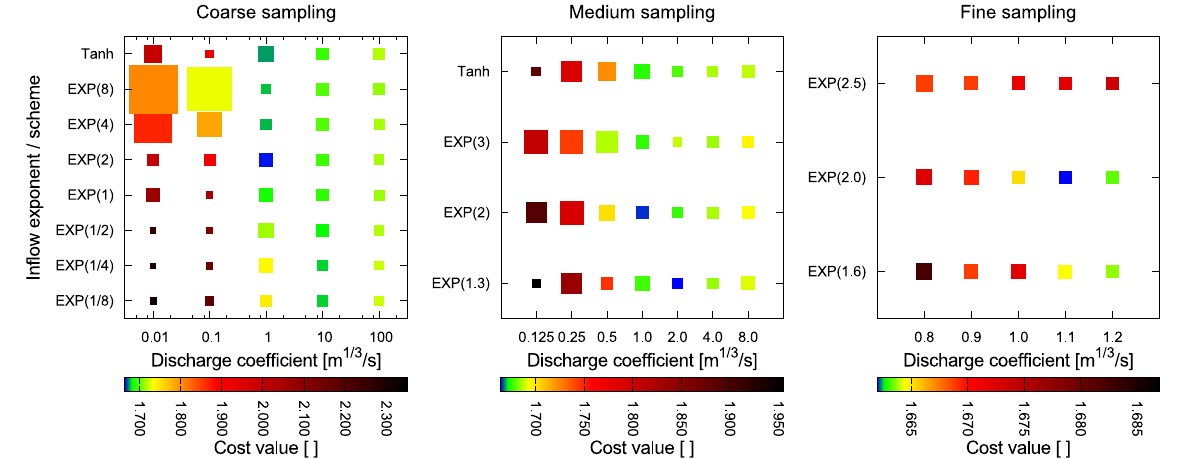
Fig. 4. Optimisation results for MPI-HM simulations with prescribed wetland extent. The color indicates the skill of the simulation in respect to river discharge observations (low values are best) and the size of the square indicates its robustness (inverse standard deviation, large squares are most robust). The sampling of parameter space of discharge coefficient and inflow parametrization is gradually refined from left to